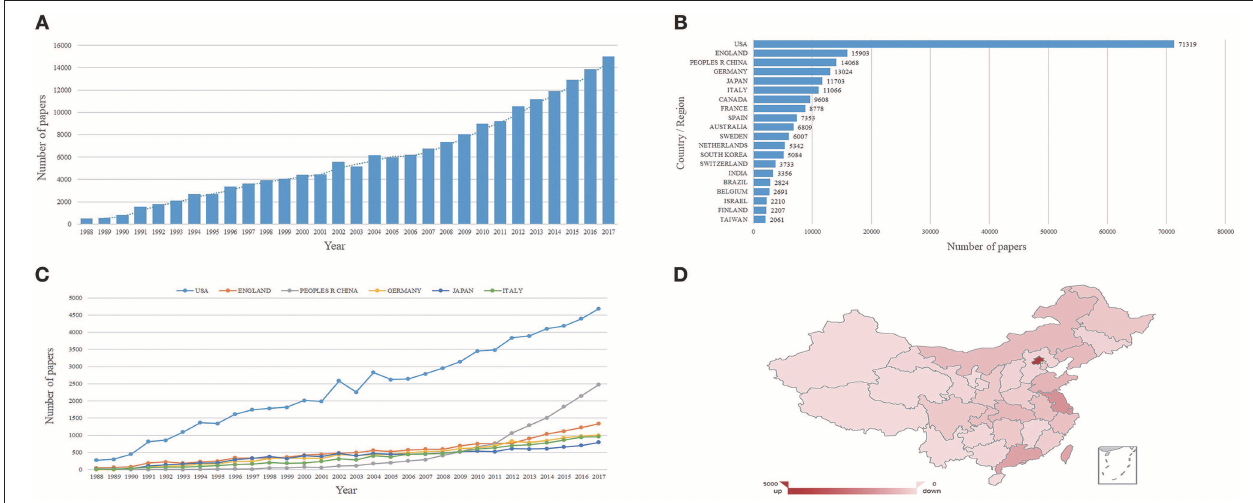
FIGURE 1 | Alzheimer’s disease (AD)-related articles globally and in China. (A) Global number of AD-related publications. Blue bars indicate the quantity of AD articles. (B) Sum of AD-related articles from the top 20 countries and territories. (C) AD articles published from the top six countries over time. (D) Heat map showing the distribution of AD publications in